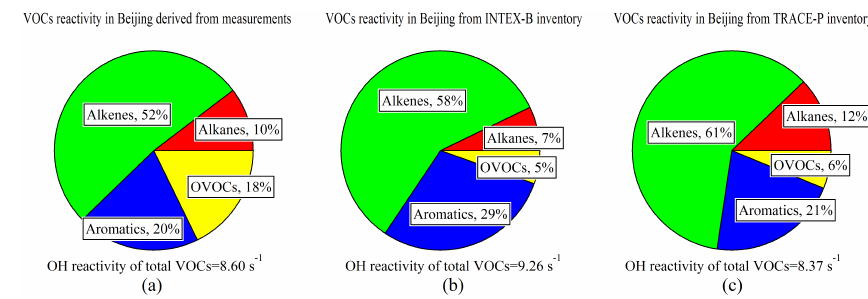
Figure 11. Comparison of the relative contributions of VOC groups to the total OH reactivity for measured VOC species in Beijing from (a) measurements, (b) the INTEX-B inventory (Zhang et al., 2009), and (c) the TRACE-P inventory (Streets et al., 2003). The OH reactivity for each VOC species was calculated as the product of its emission ratio, rate constant with OH ( k OH ) , and an assumed CO mixing ratio